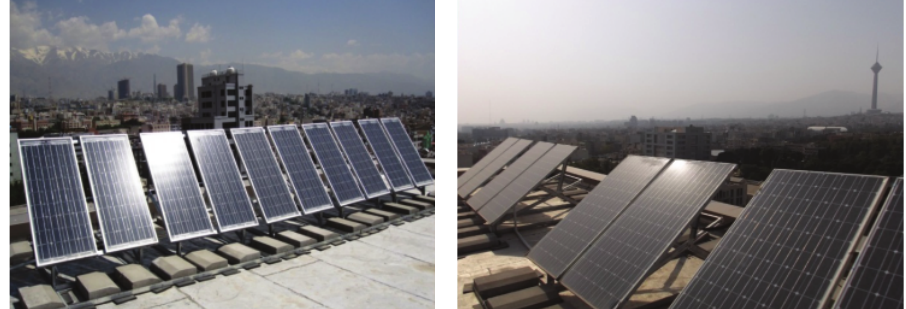
Figure 1: University of Tehran’s Photovoltaic Plant Complex (Source: